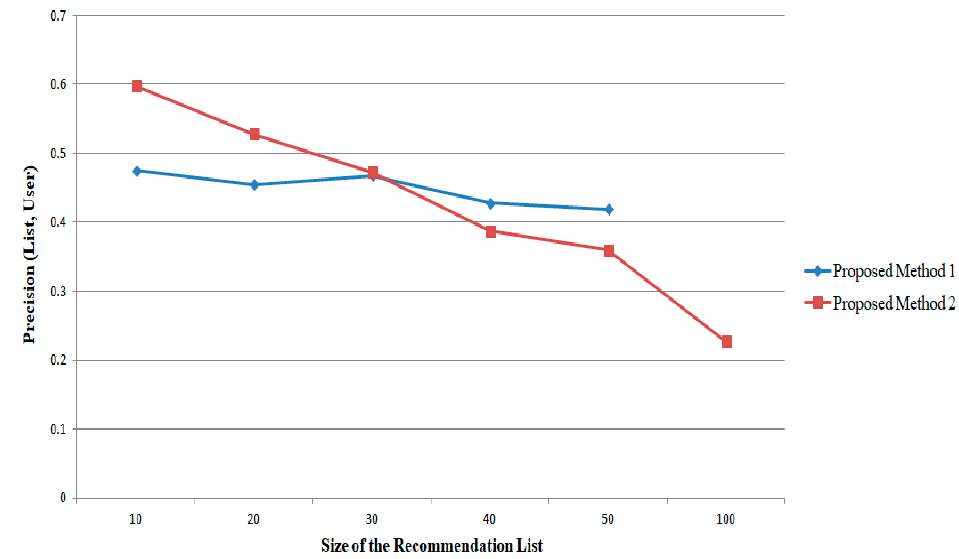
Figure 9. Size of the Recommendation List versus Precision ( List , User ) for Book-Crossing .